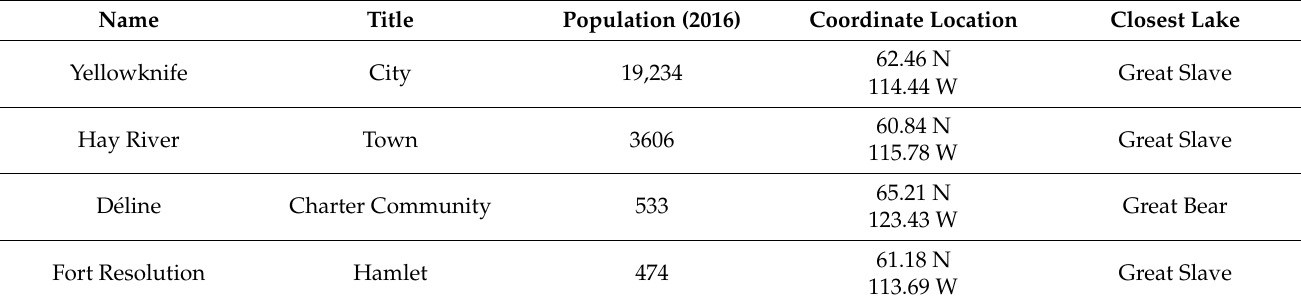
Table 1. Description of each study regions’ title, population, geographic coordinates, and associated Great